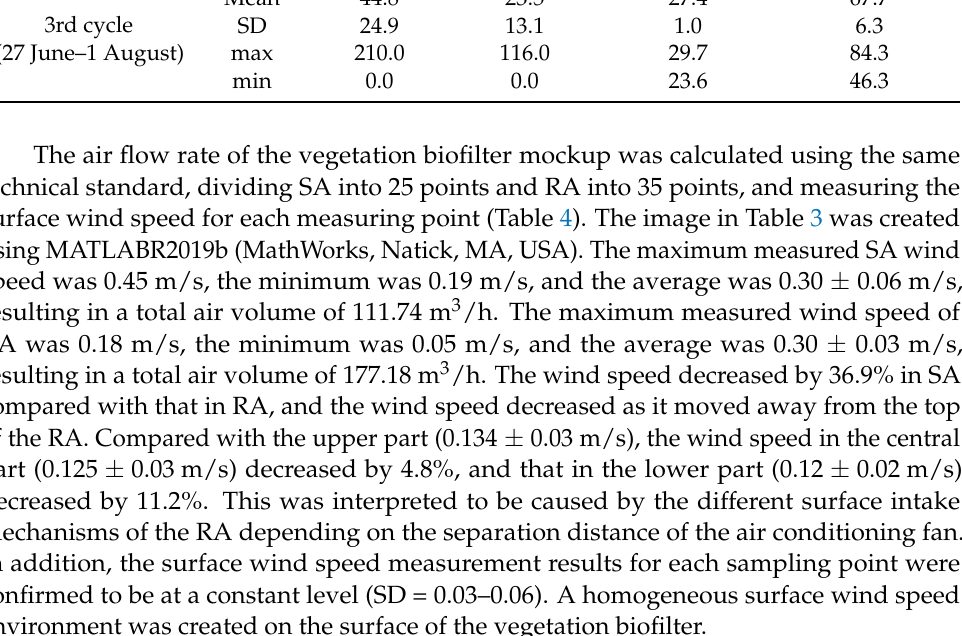
Atmosphere 2021 , 12 , x FOR PEER REVIEW